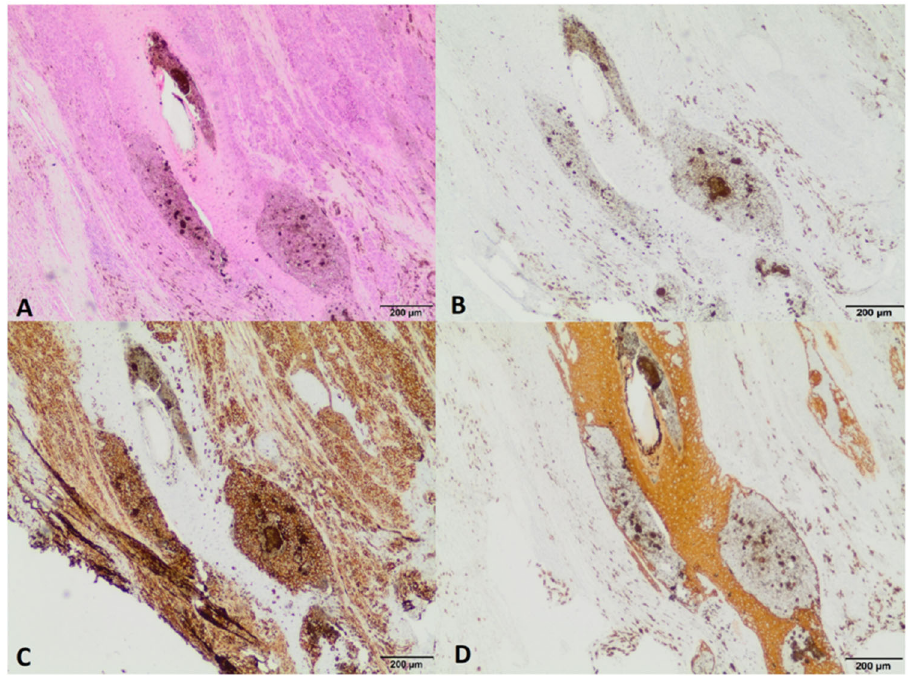
Figure 10. ( A ): infiltration of neoplastic cells to the dermis, HE staining, magn. 40×; ( B ): expression of Melan ‐ A in the cytoplasm of neoplastic cells, magn. 40×; C: expression of vimentin in the cyto ‐ plasm of neoplastic cells, magn. 40×; D: negative staining for cytokeratin, magn. 40×.